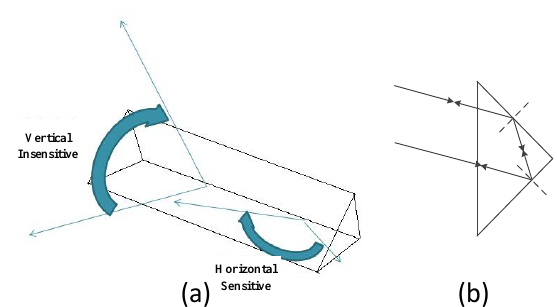
Figure 7 Altitude difference between Polaris and sensor in the theodolite coordinate